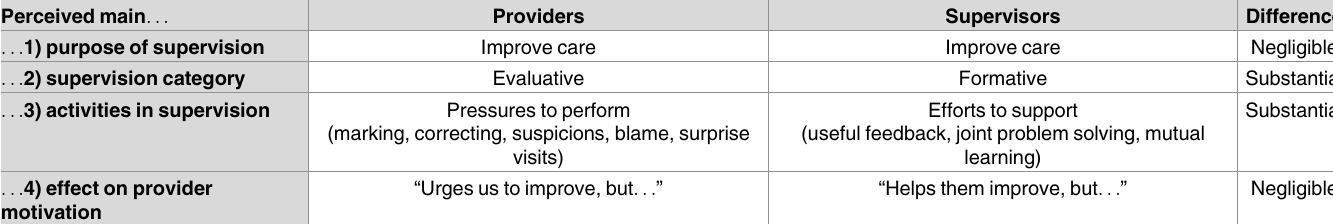
Table 4. Comparison of supervisors’ and providers’ main perceptions of supervision on four conceptual levels. Perceived main